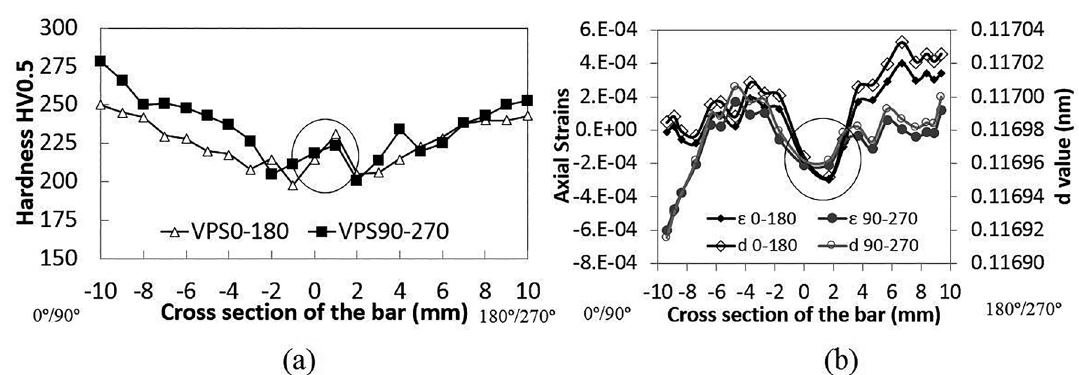
Figure 7. (a) Experimental Hardness (HV0.5) and (b) the axial strain and the d value in the bar cross section in the section 0°-180° and 90°-270° for vertical pre-straightening